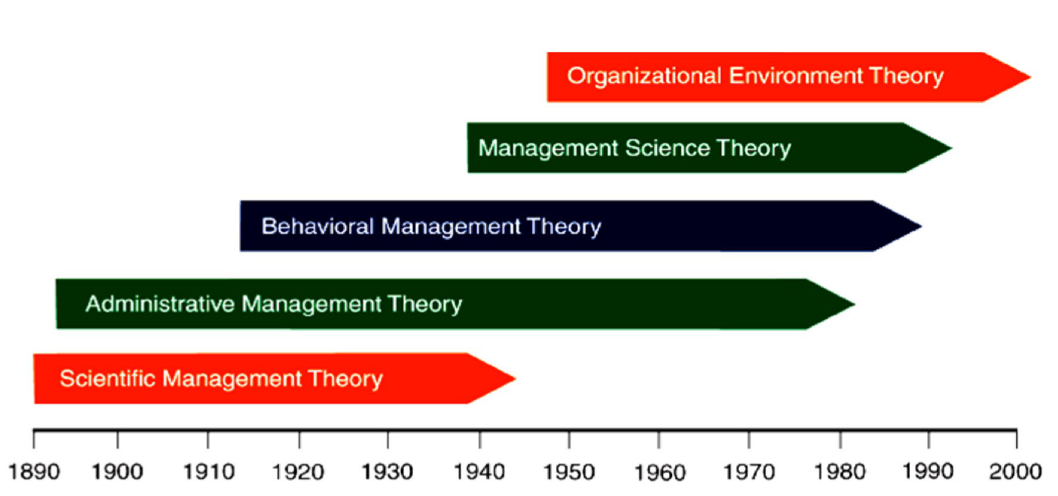
Figure 1. Evolution of Management Science (Smit, Cronje, Brevis & Vrba,